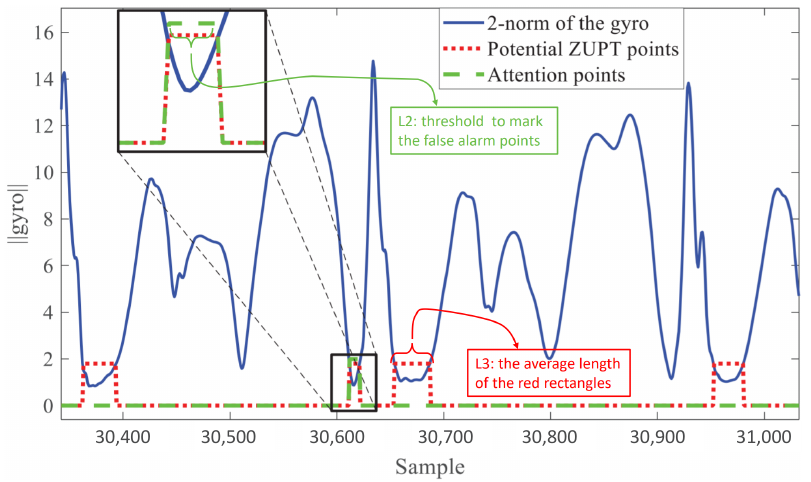
Figure 3. Two-norm value of the gyroscope data during a running sequence. Note that points encircled by small green rectangles (dashed lines) may be false alarm points, which would damage the trajectory, especially during the motion types of fast walking and